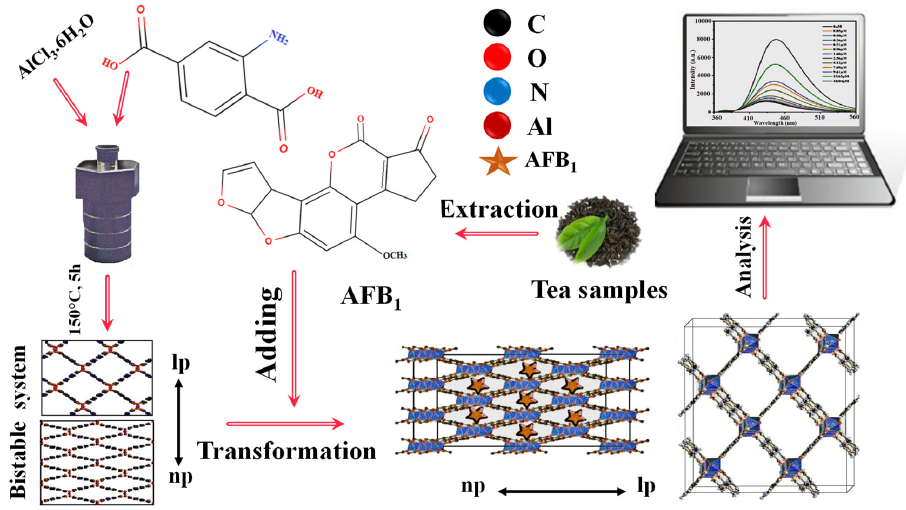
Figure 9. Graphic depiction of fluorescent aflatoxin B1 detecting employing fluorescent metal-organic frameworks. Adapted with permission from the article [96]. 2022, Elsevier.